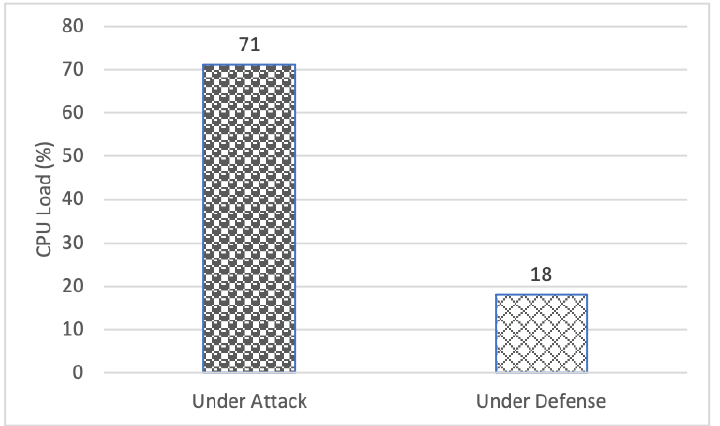
Figure 10. Average SIP server CPU load after the attack and after the mitigation for all types of